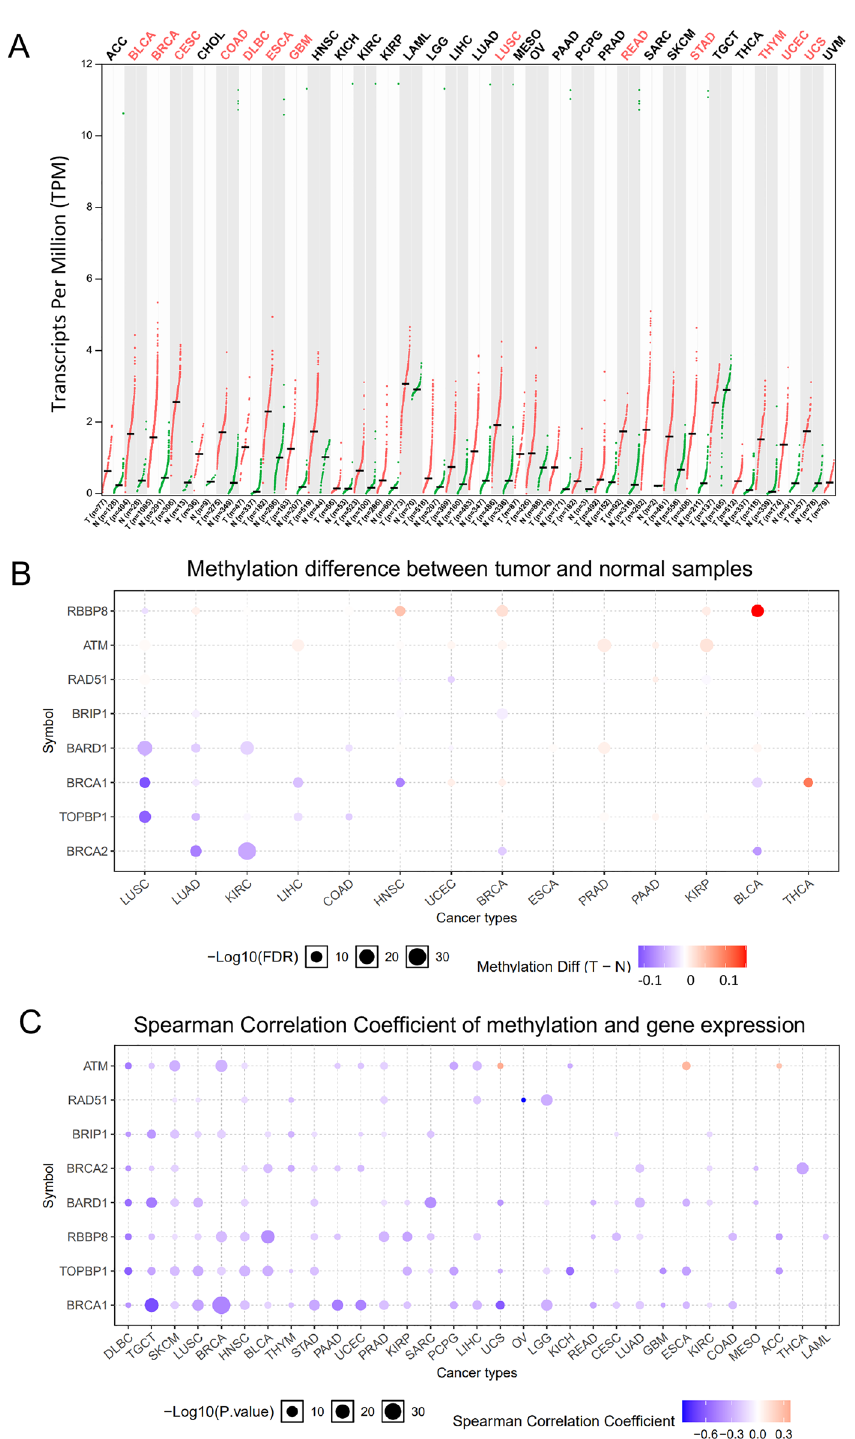
Figure 1. The mRNA expression and methylation levels of BRIP1 in TCGA cancer tissues. ( A ) BRIP1 mRNA expression between tumors and the matched adjacent normal tissue in various TCGA cancer types from GEPIA ( p < 0.01 was set as statistically significant). ( B ) Bubble map showing the methylation differences of BRIP1 and downstream gene in 14 different cancer types between tumors and matching normal tissues. Cancers with red dots have higher levels of methylation, whereas those with blue dots have lower levels of methylation (T: tumor; N: the paired normal tissue). ( C ) Across cancer types, a bubble map demonstrates the relationship between methylation and the expression of BRIP1 and downstream genes. The upregulated methylation level and expression level are represented by red dots, whereas the upregulated methylation level and downregulated expression level are represented by blue dots. The size of the point in the two-bubble map shows statistical significance, with a bigger size indicating greater significance. The difference is represented by the color depth of the point; the greater the contrast, the darker the color. TPM, transcripts per